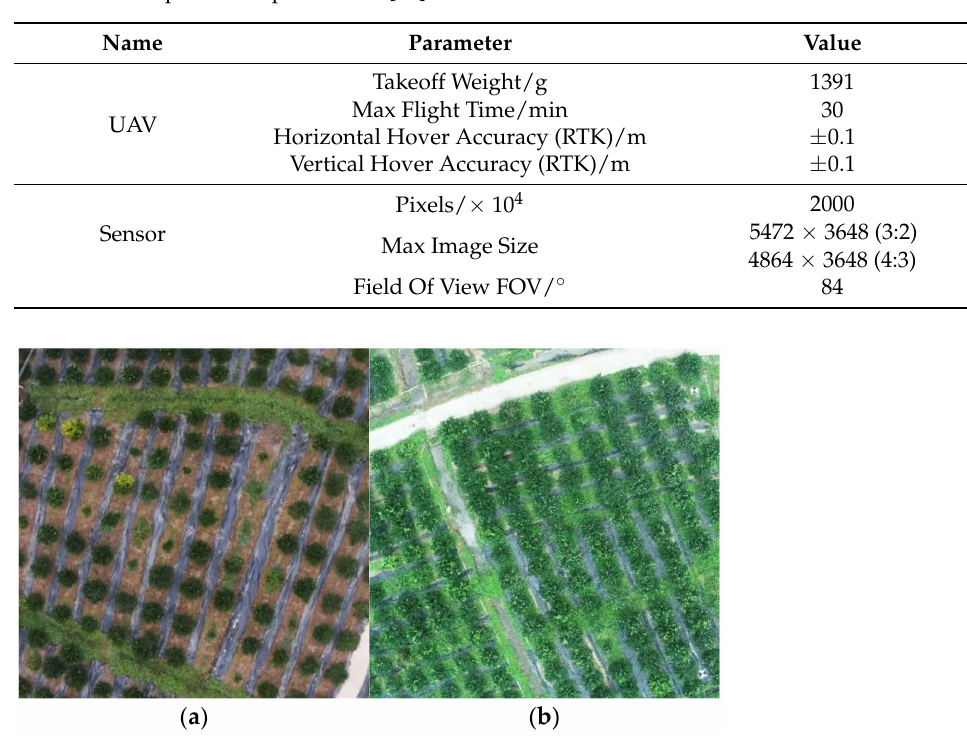
Table 1. UAV operational parameters [33].